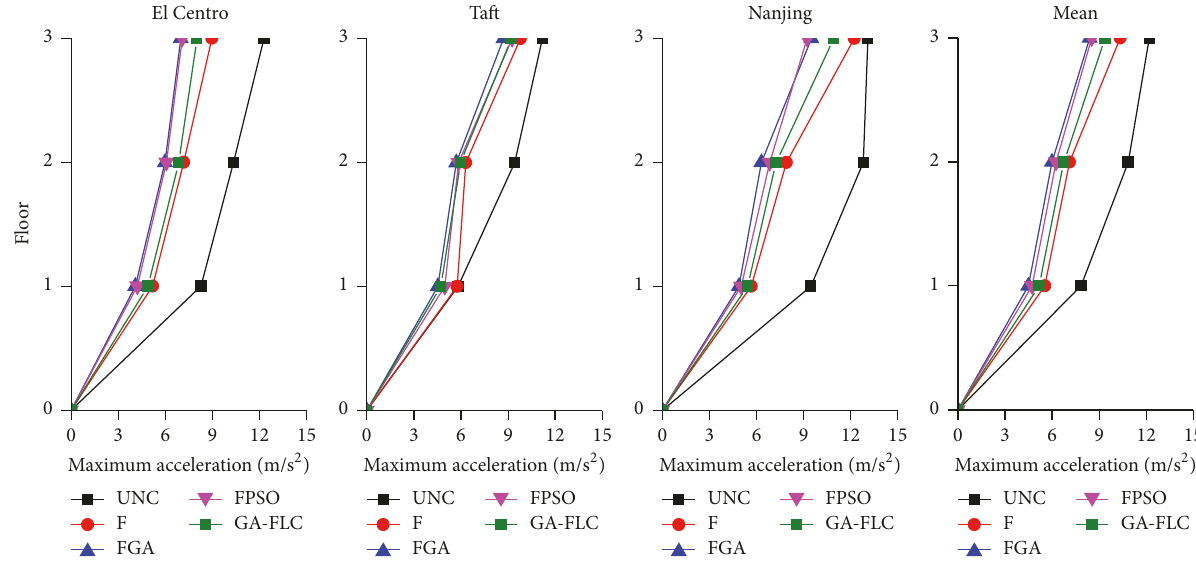
Figure 22: Each layer’s acceleration response peak under the action of three seismic waves.